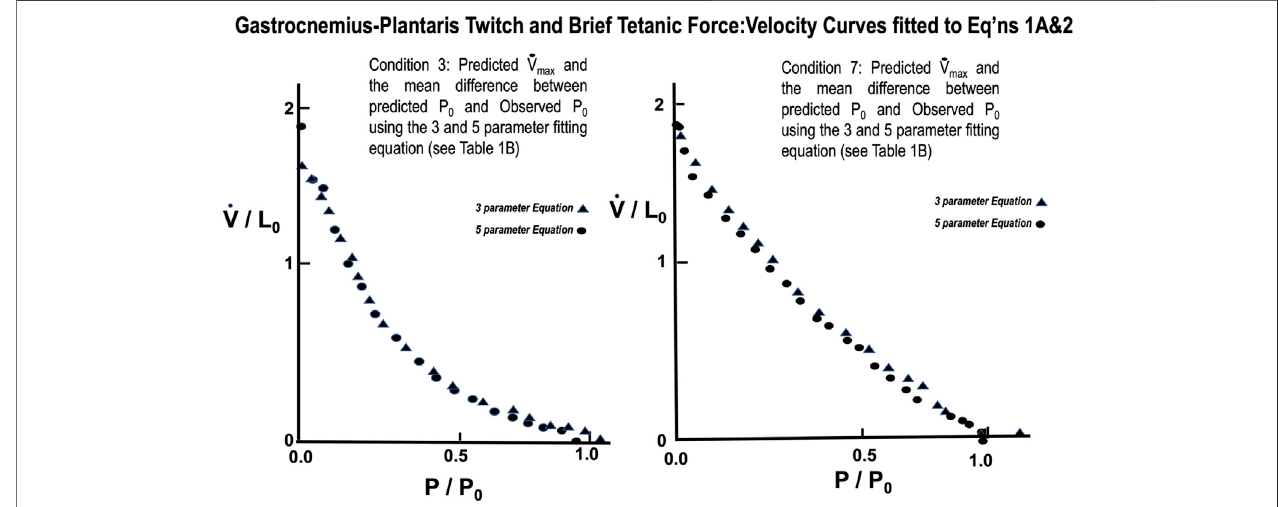
FIGURE14| ForceVelocitycurvesofobserveddatafromgastrocnemius-plantariswithTwitch(L)andBriefTetanic(R)stimulations fi ttedto Eqs1A , 2 .Comparison of the fi t for the two equations was signi fi cantly better for Eq. 2 ( p < 0.05).